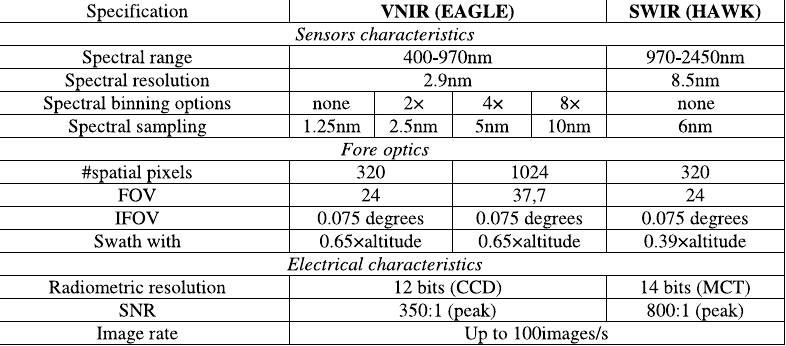
Table 1. Technical specification of AISA DUAL hyperspectral